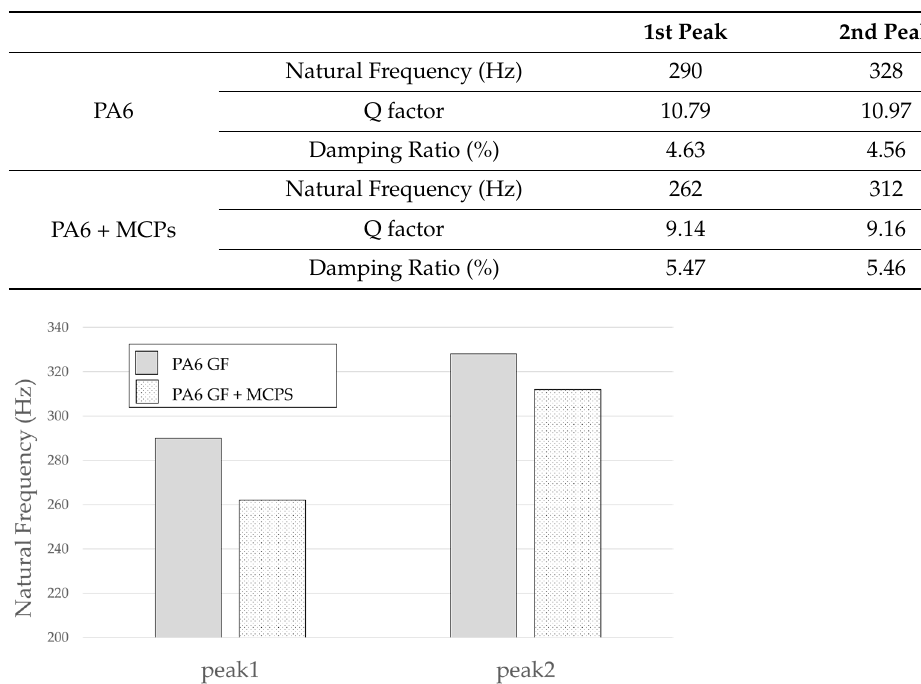
Figure 7. Effects of MCPs on damping ratio of plate specimen. 3.2. Sound Response of Plate Specimen As shown in Figure 8, the sound response of the plate specimen was confirmed to exhibit a similar tendency to the vibration response. The resonant frequency shifted downward, and the response sensitivity decreased; this is because the vibration charac- teristics generated by vibrating the plate-shaped specimen were expressed as radiated sounds, exhibiting a similar tendency. This tendency appears to be advantageous for product design, whereby the product is designed to be far from the source emitting the resonant frequency. If the frequency needs to be reduced by reducing the stiffness, the sensitivity increases, and side effects can occur. In this case, the frequency can be lowered but the sensitivity is reduced accordingly. Therefore, many possible applications are ex- pected.